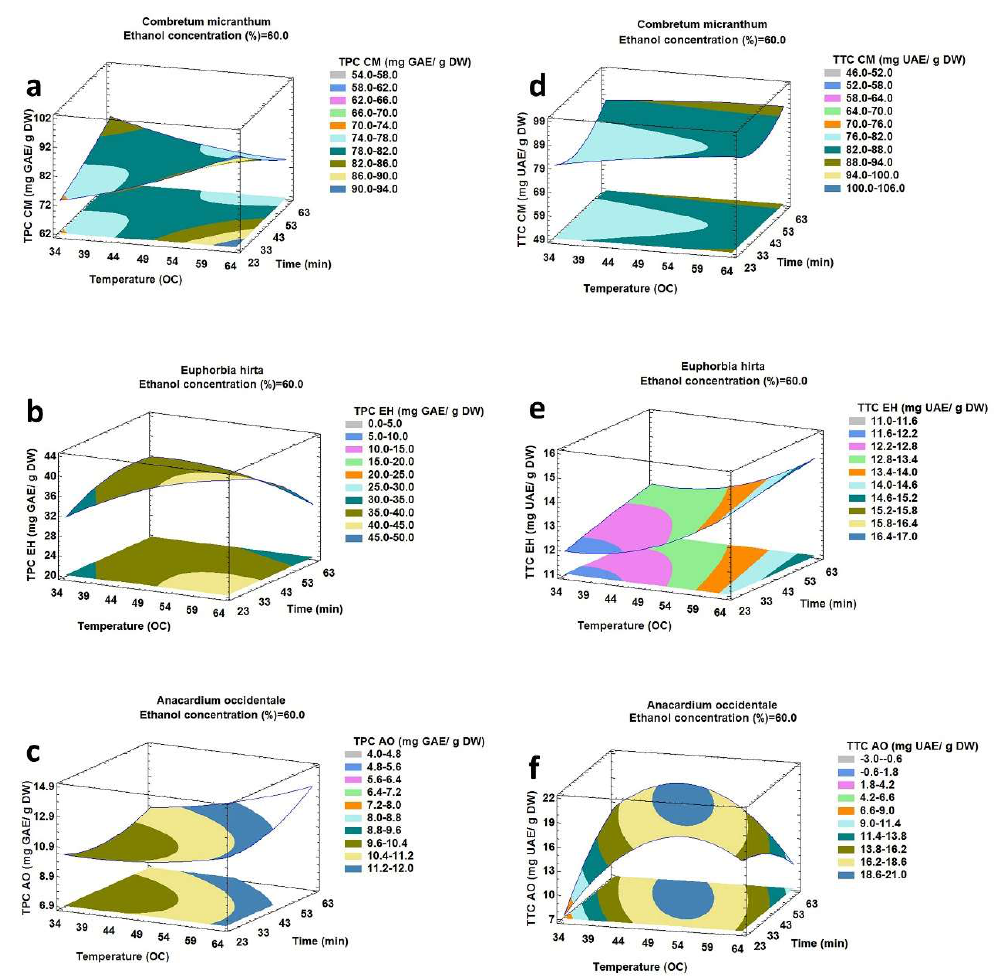
Figure 3. Response surface plot showing the effect of extraction temperature and extraction time on total phenolic and total triterpenoid compounds from Combretum micranthum ( a , d ), Euphorbia hirta ( b , e ) and Anacardium occidentale ( c , f ) corresponding to ethanol concentration of 60%.